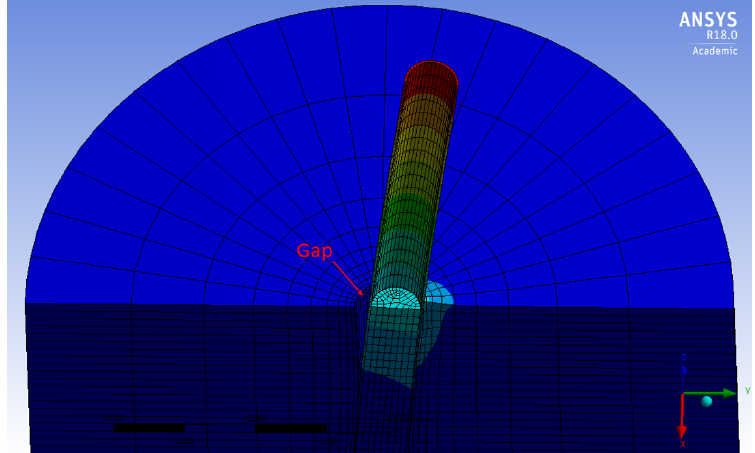
Figure 4. Illustration of the formed gap between pile and soil during analysis of lateral load.